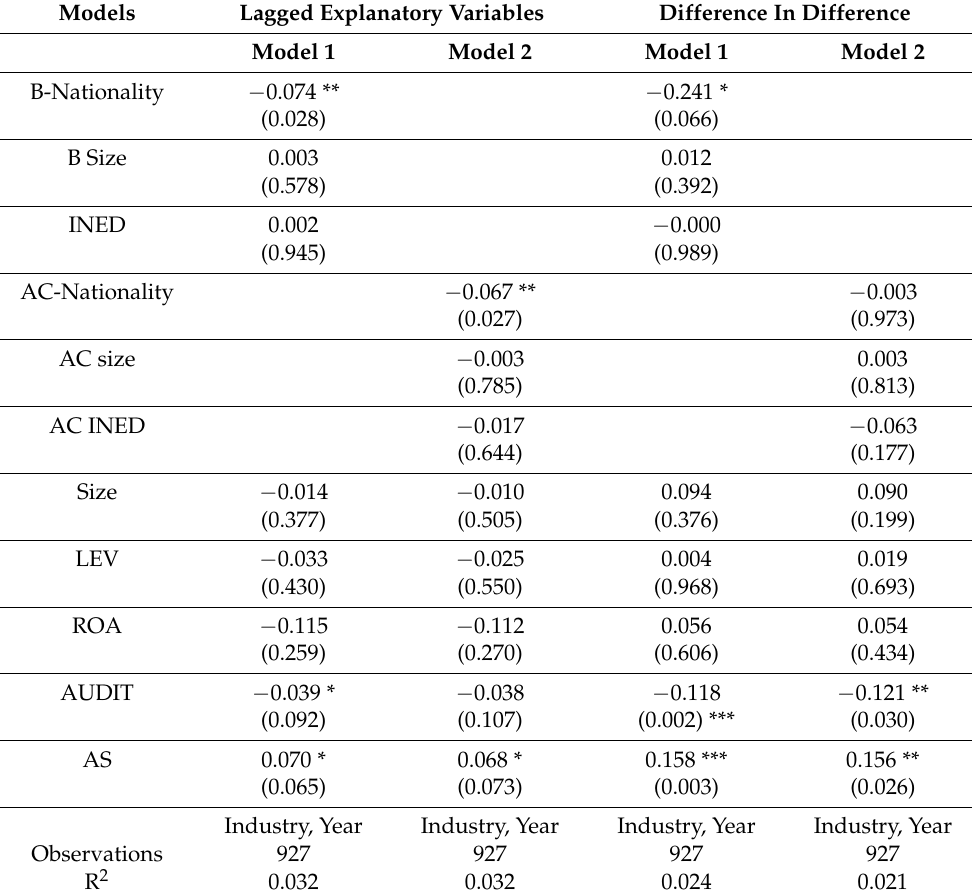
Table 5. Robustness